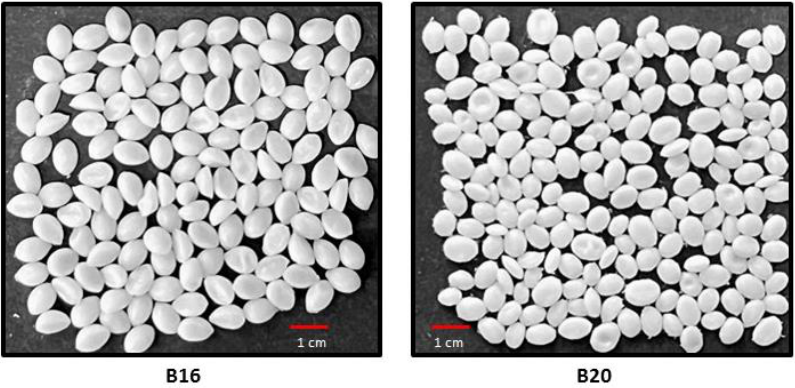
Figure 1. B16 and B20 granules. Scale bar is 1